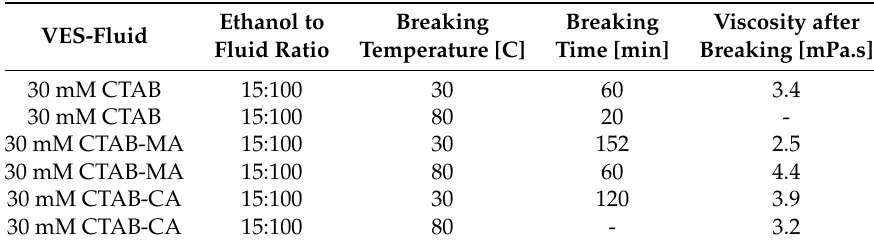
Table 2. Summary of the breaking properties of different VES fluids at ethanol to fluid ratio of 15:100 and different temperatures.